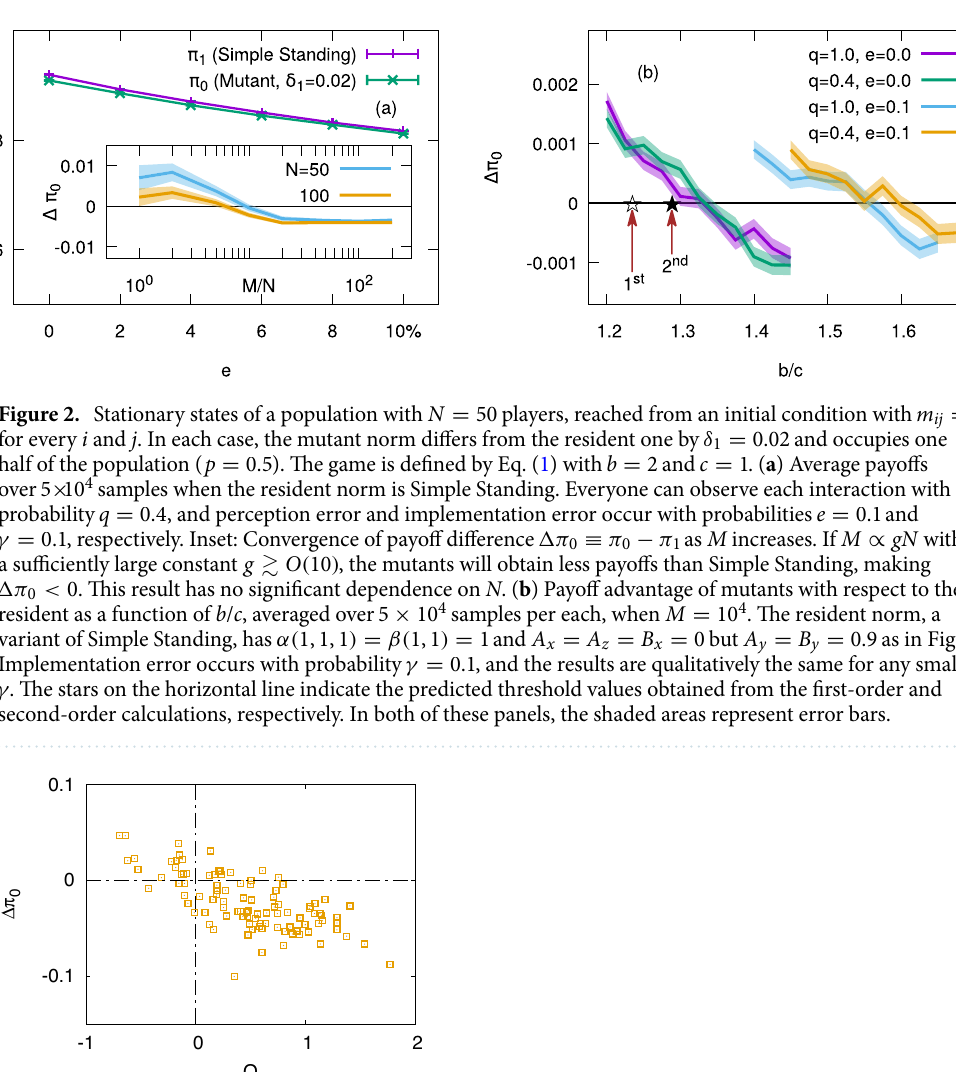
threshold value is consistent with the first- and second-order calculations [the arrows in Fig. 2b]. When e > 0 , on the other hand, the threshold is pushed upward, implying that cooperation becomes harder to stabilize because of the perception error. In addition, we now see that incomplete information with q < 1 can shift the threshold further with the aid of positive e . We have also changed the value of γ , but it does not not change the average behaviour in the above results. Overall, the point of Fig. 2b is that our analysis does capture the correct picture. Finally, we can numerically check the effect of a ‘slope mutant’, which has α( 1, 1, 1 ) = 1 as a fixed point and the same behavioural rule as Simple Standing but differs in the slopes A x , A y and A z . To be more specific, let us assume that a mutant norm occupies 10% of the population whereas the rest of them are using Simple Stand- ing. The values of α( x , y , z ) at the vertices of the three-dimensional unit hypercube are randomly drawn from the unit interval, except for α( 1, 1, 1 ) = 1 . Then, the trilinear interpolation is used to construct the continuous assessment rule. According to our simulation (Fig. 3), the performance of the mutant norm is strongly cor- related with its Q -value [Eq. (17)]. Recall that the expression of Q has been derived in the context of recovery from small disagreement in a homogeneous population. Figure 3 nevertheless suggests that it can also serve as